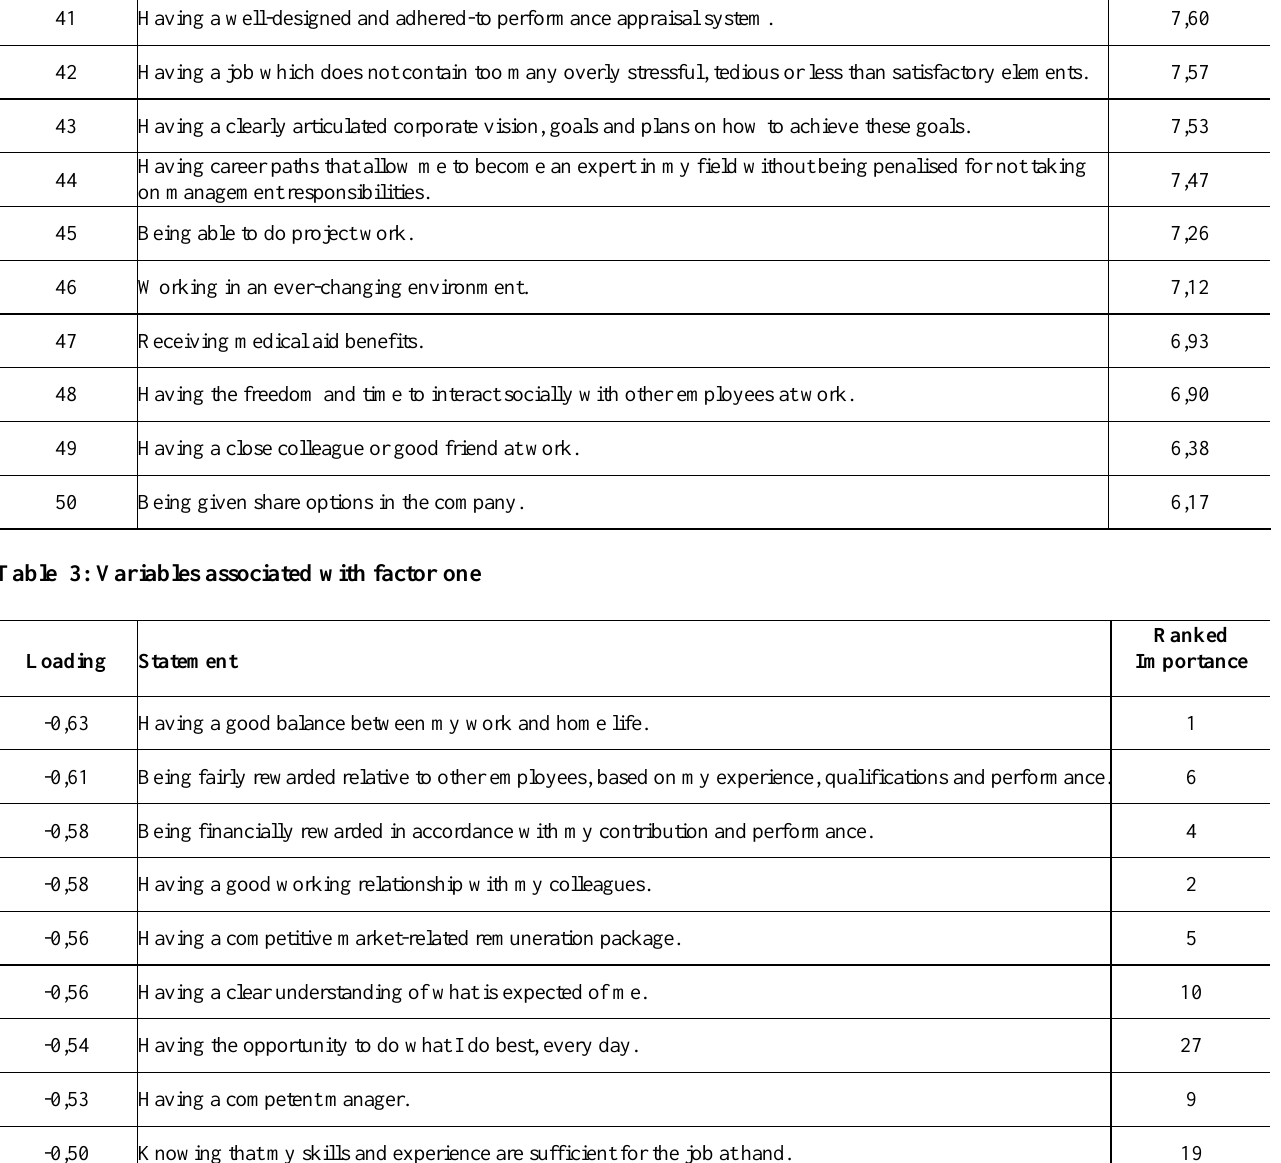
Table 2 : The bottom ten variables Ranking Variables that influence retention